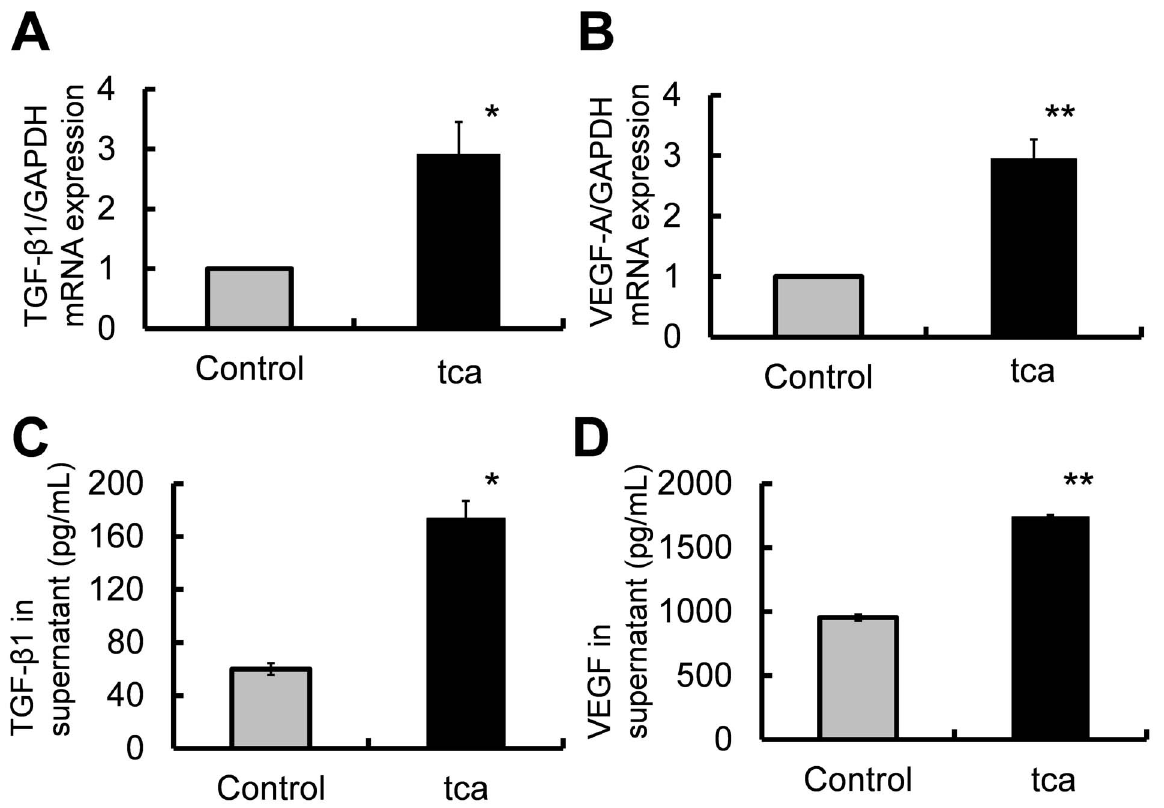
Figure 2. Quantification of TGF- b 1 and VEGF-A mRNA and protein levels. (A, B) Control cells were cultured in the medium without TCA and tca cells were cultured in the medium with 2 mM TCA. Total RNA was extracted from these cells and expression levels of TGF- b 1 and VEGF-A mRNA were evaluated by qRT-PCR. (C, D). Culture supernatants were collected from control cells incubated in the medium without TCA and tca cells incubated in the medium with 2 mM TCA for 24 h. (A) TGF- b 1 mRNA levels in tca and control cells (* P , 0.05). (B) VEGF-A mRNA levels in tca and control cells (** P , 0.01). (C) Comparison of the mean level of secreted TGF- b 1 in the media from tca vs. control cultures (** P , 0.01). (D) Comparison of the mean level of secreted VEGF protein for tca vs. control cells (** P , 0.01).